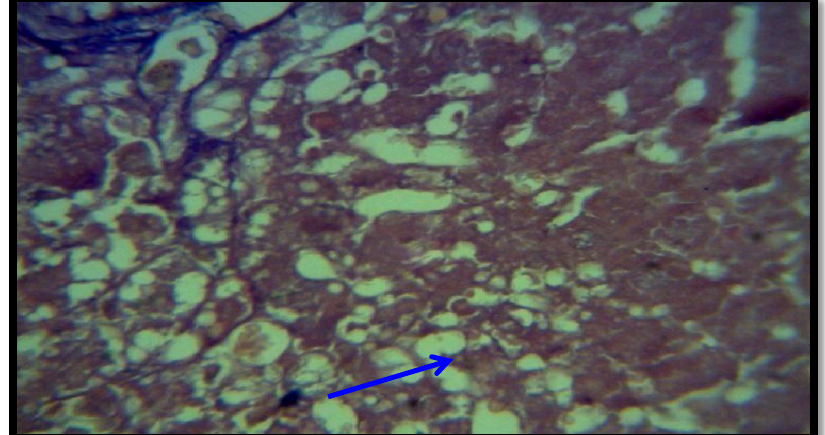
Figure (4):- Histological section in the liver of rat received 150 mg/kg B.W. of DPP suspension +1ml/kg B.W. of CCL4 with olive oil for 42 days , shows moderate vacuolation in hepatocyte (H and E, x